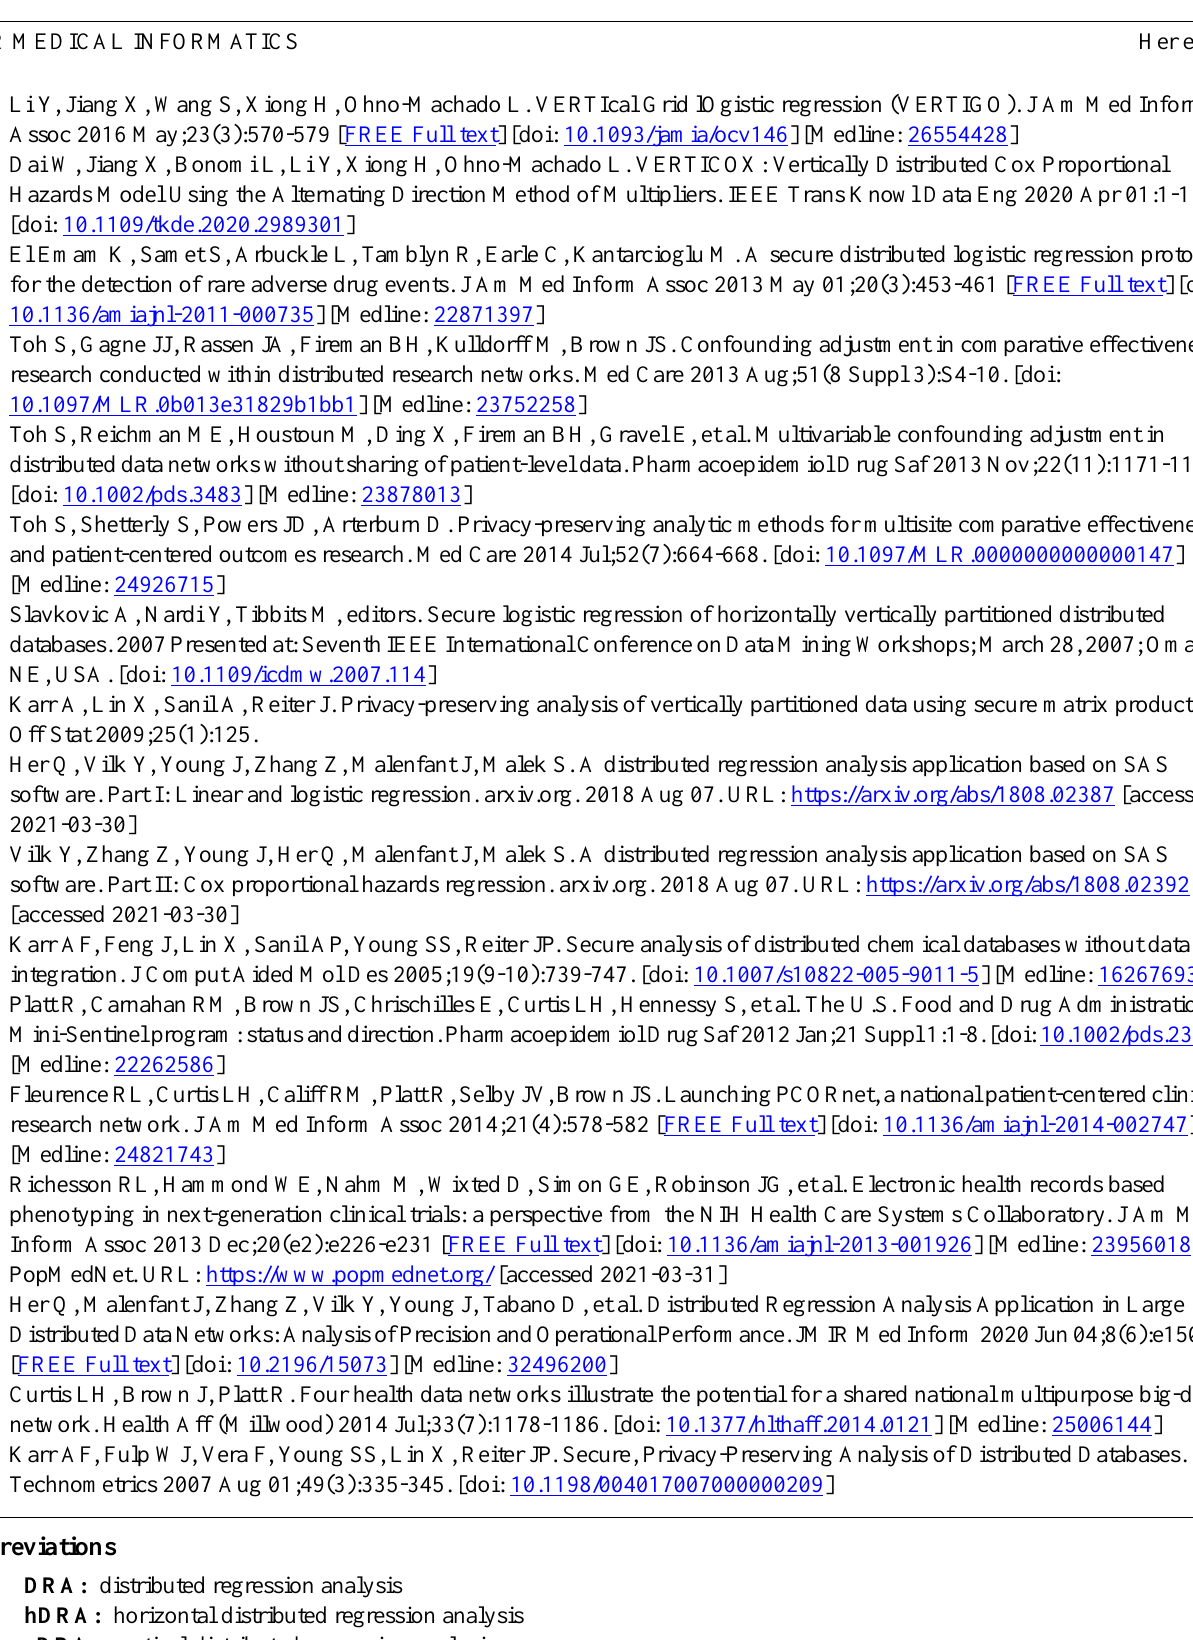
Abbreviations DRA: distributed regression analysis hDRA: horizontal distributed regression analysis vDRA: vertical distributed regression analysis VERTIGO: VERTIcal Grid lOgistic